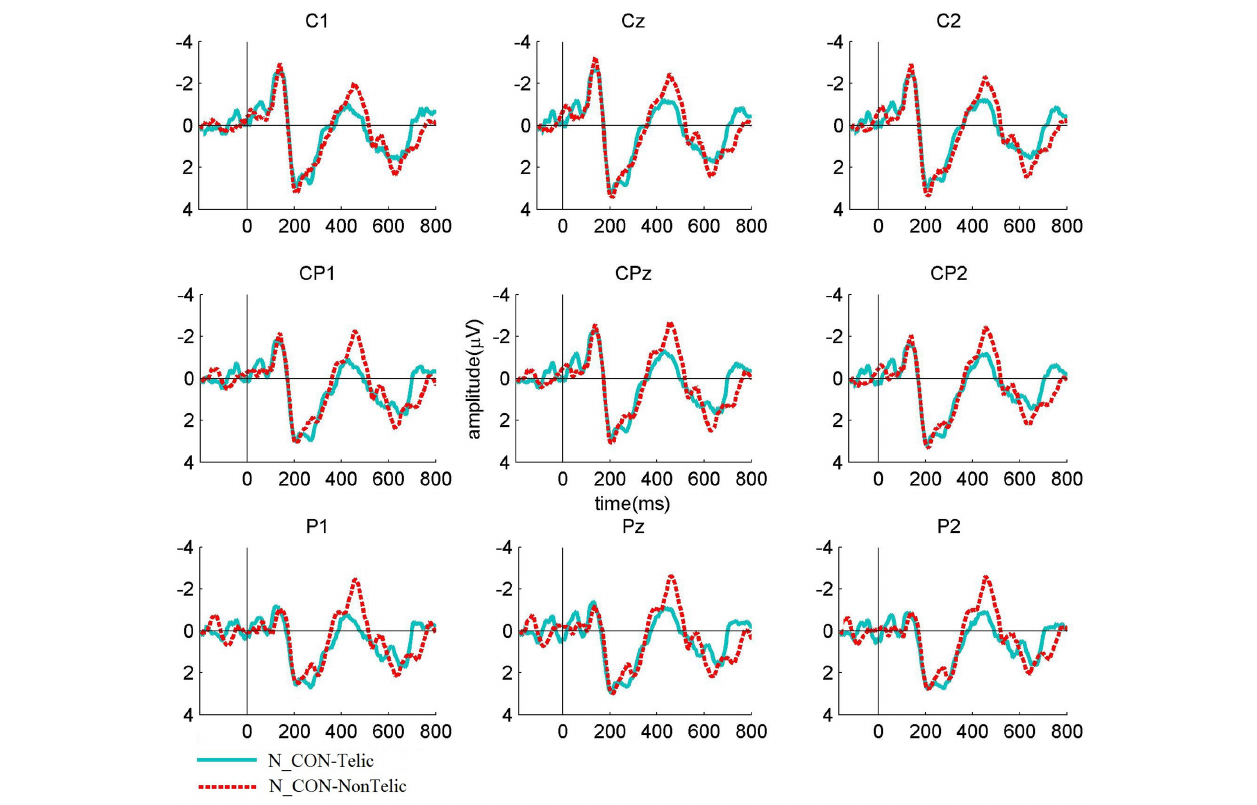
FIGURE 1 | Grand average waveforms elicited by the verbs in Telic vs. NonTelic combinations in Neutral contexts (N_CON) for nine centro-parietal channels. The waveforms show a significant N400 effect.